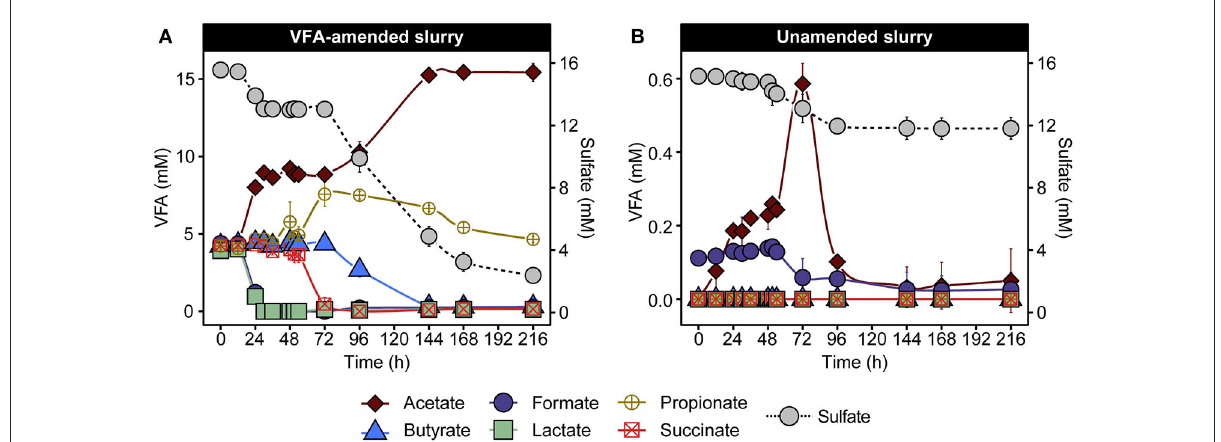
FIGURE1 VFA and sulfate concentrations in VFA-amended (A) and unamended (B) sediment slurry incubations at 50 ◦ C. Data are presented as mean ± the standard deviations from three replicate slurries. When not shown, the error bars are smaller than the symbols. Note different scales in the left y-axis in (A,B) owing to the different initial concentrations of